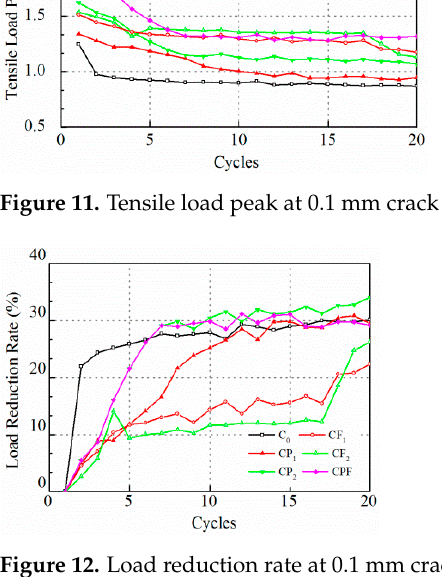
Figure 14. Initial tensile load for 0.2 mm crack opening. Clearly, the fiber and polymer compound modification can improve the cracking re- sistance significantly. The improvement of the maximum tensile load is attributed to three influence factors. Firstly, the polymer can fill the voids inside the concrete; secondly, the introduction of fiber can obstruct the propagation of the microcracks; and lastly, the car- boxylated styrene–butadiene latex was an adhesion agent, which can adhere both the high-efficiency hydroxylated carboxylic acids on the surface of concrete and the polyformaldehyde fiber. 5.3. Impact Loading Test Results Impact resistance tests were performed after the concrete was cured for 28 days at 20 °C, 95% RH. In this study, the standard cube specimens of 150 × 150 × 150 mm were tested directly without trimming. Unfortunately, all the specimens for the seven groups sustained more than 500 impacts prior to cracking occurrence. Moreover, there was no cracking found for C 0 even with number of blows up to 5000 times. As it is shown in Figure 15a,b, the rammer penetrated into the specimen after 5000 blows of impact loading, but no cracking occurred . In other words, trial test results showed that the impact loading with 150 × 150 × 150 mm specimens was too time-consuming to evaluate the impact re- sistance of different mixtures. Therefore, to improve the test efficiency of impact loading, the standard cube specimens were trimmed with a sawing device to different sizes of 150 ×150 ×T mm, where T was the thickness of trimmed specimens under the rammer, which varied at 150 mm, 120 mm, 100 mm, 70 mm, 50 mm, and 35 mm.